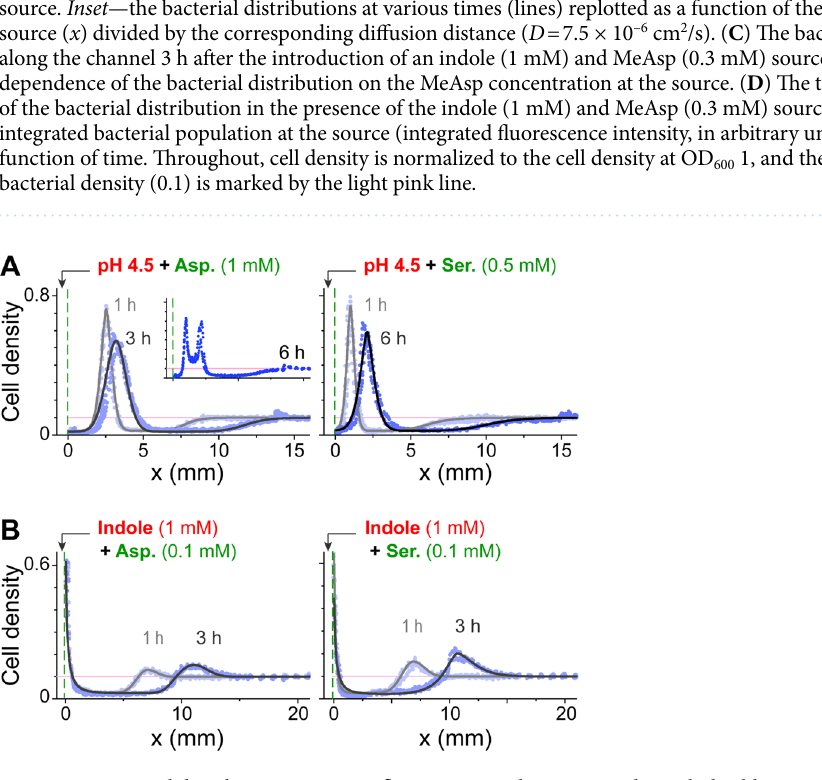
Figure 3. Bacterial distribution near a conflicting source that contained metabolizable attractants. The bacterial distribution measured at various times after the introduction of a source containing either low pH ( A ) or indole ( B ) along with either aspartate (left) or serine (right). Inset (upper left plot)—the bacterial distribution along the channel 6 h after the introduction of the low-pH and aspartate source. Throughout, cell density is normalized to the cell density at OD 600 1, and the initial uniform bacterial density (0.1) is marked by the light pink